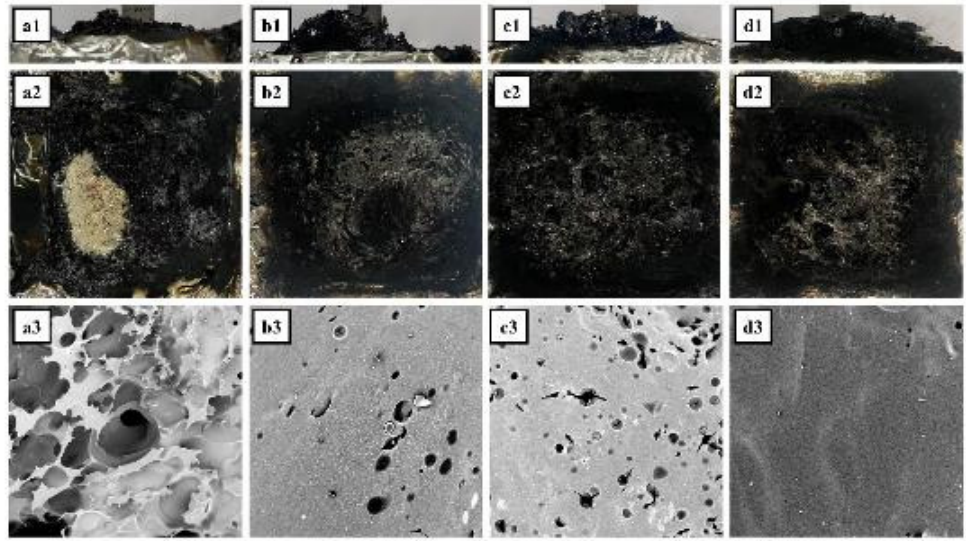
Figure 4. Macroscopic photos ( a1 , a2 , b1 , b2 , c1 , c2 , d1 , d2 ) and SEM images ( a3 , b3 , c3 , d3 ) ( × 500) of residues for PET, PBPP/PET, PBPDP/PET and PBDP/PET.